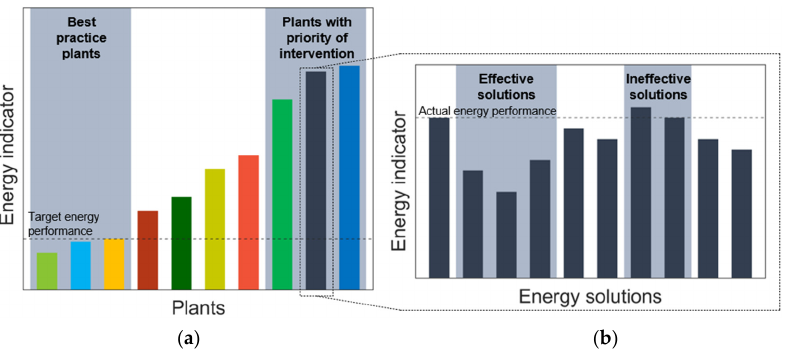
Figure 6. Applications of energy indicators: ( a ) energy performance evaluation; ( b ) energy perfor- mance improvement.